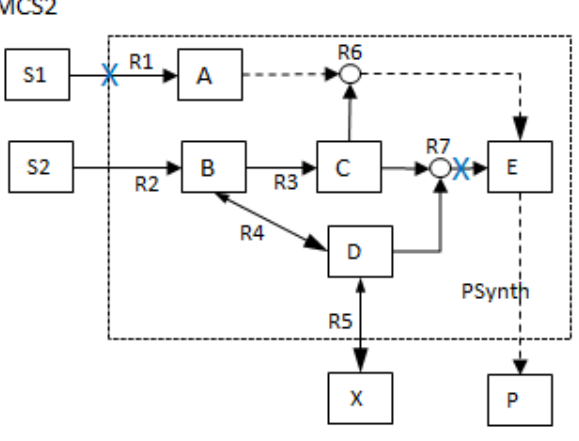
Figure 7. One of the Minimal cut sets (MCSs) for objective reaction PSynth : The simultaneous blocking of reactions R1 and R7 will eliminate PSynth and block the production of